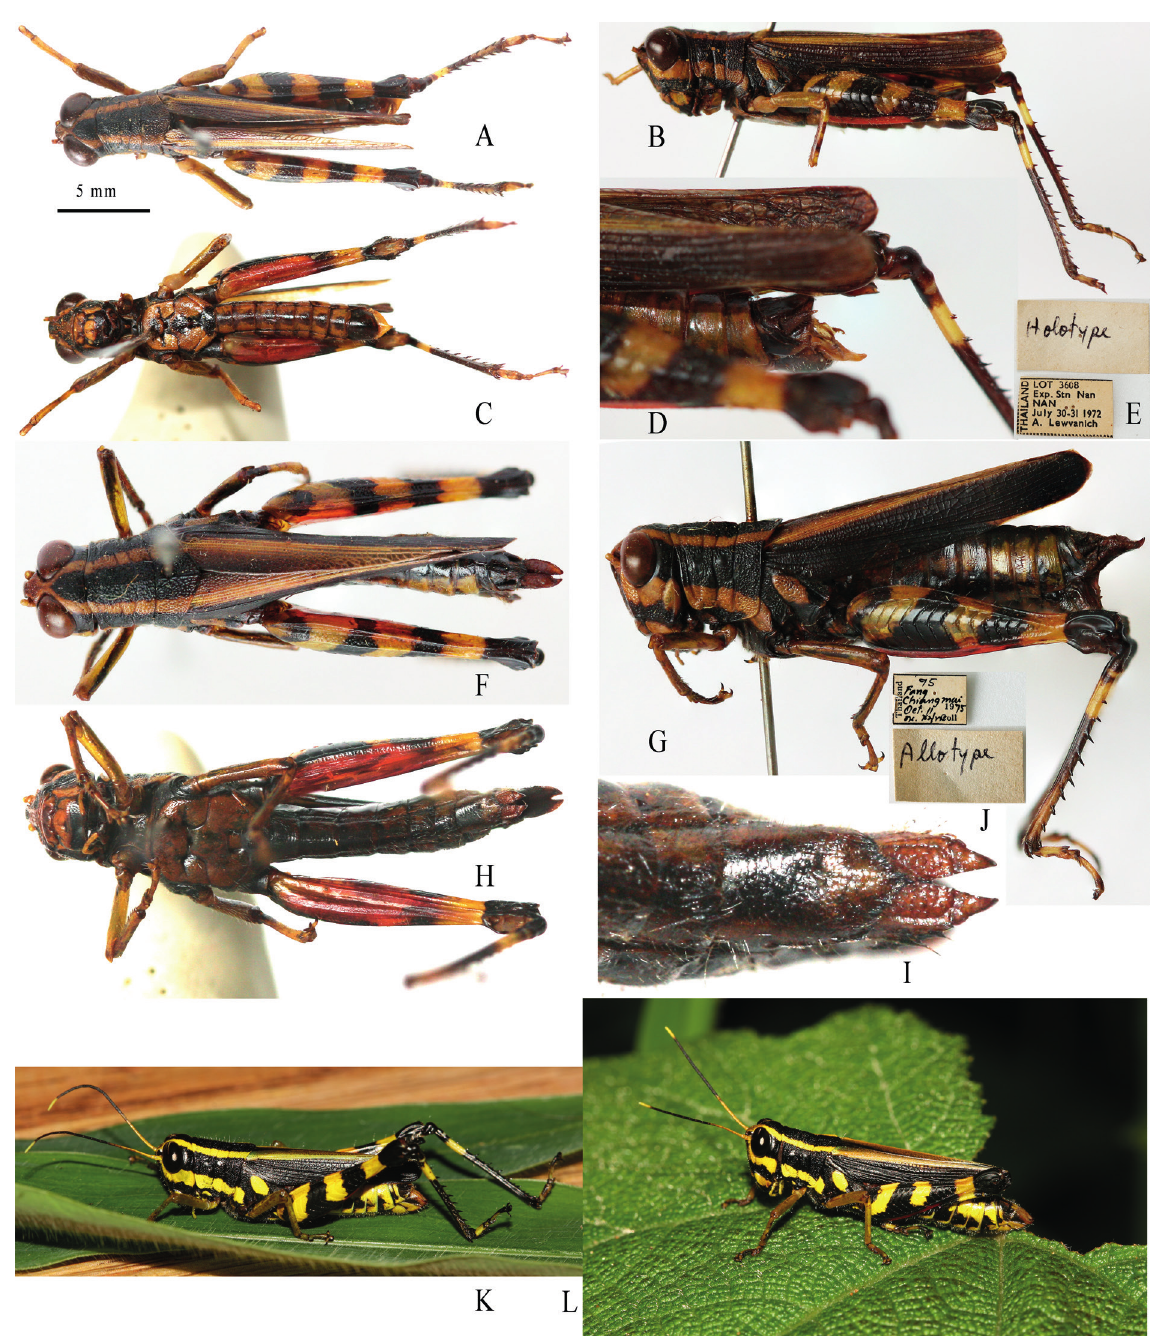
Fig. 1. Pseudotraulia cornuata Laosinchai & Jago, 1980. A–E . Holotype (DAB), ♂. A–C . Habitus in dorsal, lateral and ventral views. D . Abdominal apex, lateral view. E . Labels. F–J . Paratype (DAB), ♀. F–H . Habitus in dorsal, lateral and ventral views. I . Abdominal apex, ventral view. J . Labels. K . Living ♀ from Chiang Rai Province, Northern Thailand. L . Living ♀ from Nan Province, Northern